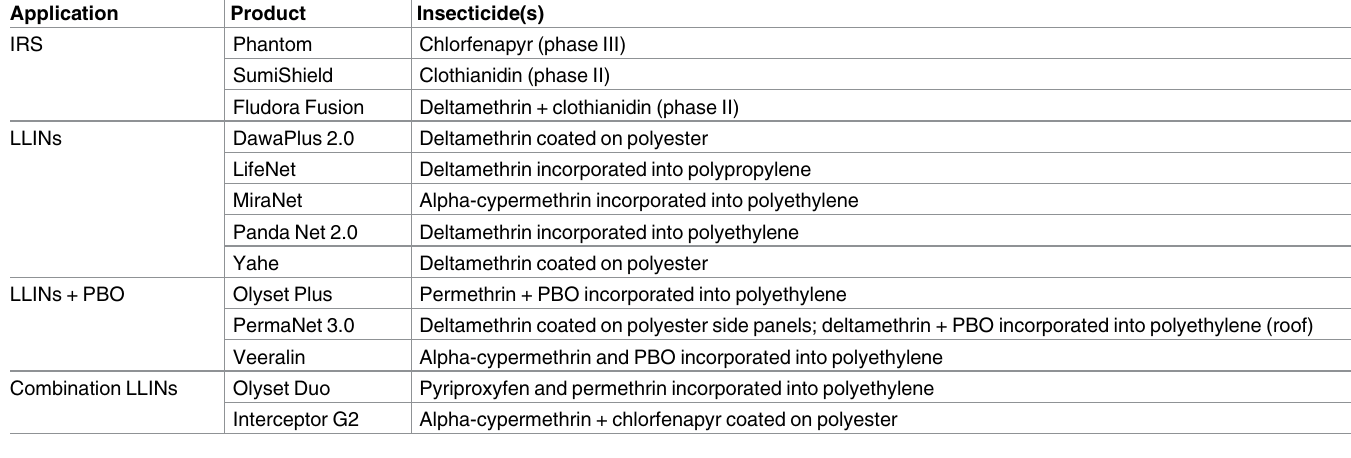
Table 1. Insecticides for indoor residual spraying (IRS) under World Health Organization Pesticide Evaluation Scheme (WHOPES) evaluation and long-lasting insecticidal nets (LLINs) in late-stage development [39–41,177,178] * .